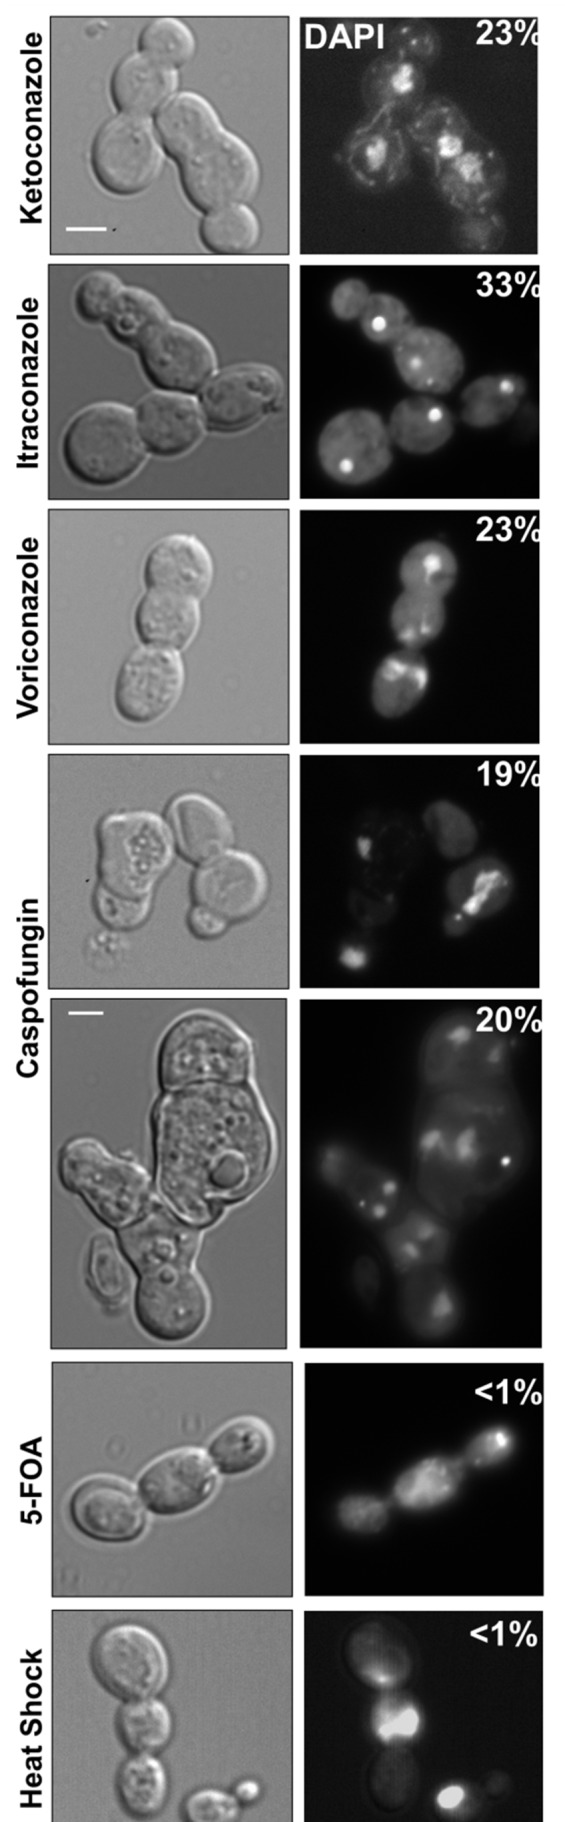
Trimera formation is not a general stress response.Cells exposed to triazoles ketoconazole, voriconazole, and itraconazole formed trimeras at frequencies similar to FLC. Cells that were exposed to caspofungin, an echinocandidn, also produced many trimera-like and multimera-like cells (upper and lower panels). Exposure to toxin 5-FOA as well as heat shock did not result in a significant number of trimeras. No trimeras were detectable following exposure to 2-DOG (unpublished data). Percentages in upper right corner of DAPI image denote frequency of trimera formation in 300–400 cells.